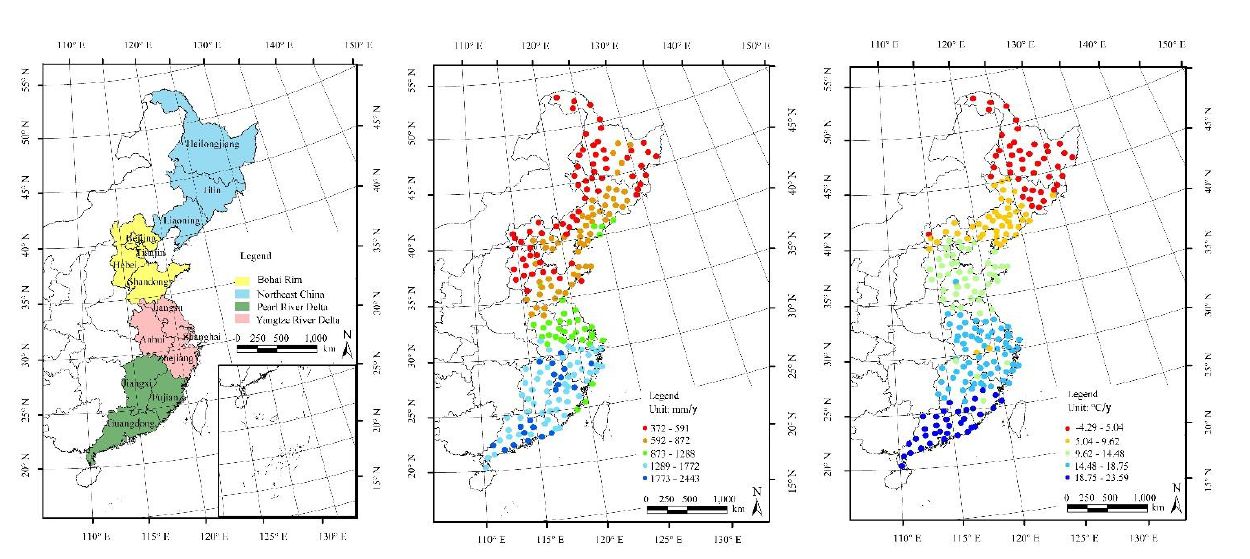
Figure 1. Location of study area in Eastern